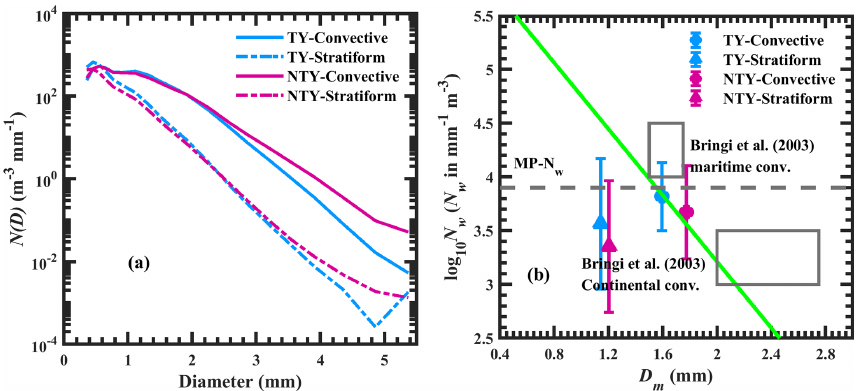
Figure 8. (a) Distribution of N(D) (m − 3 mm − 1 ) with raindrop diameter in stratiform and convective precipitation for typhoon (TY) and non-typhoon (NTY) rainfall. (b) Variations in log 10 N w (where N w is the normalized intercept parameter in mm − 1 m − 3 ) with D m (mass- weighted mean diameter in mm) in stratiform and convective regimes for typhoon (TY) and non-typhoon (NTY) rainfall. The horizontal gray dashed line is the Marshall–Palmer value of log 10 N w (3.9) for the exponential shape. The green inclined line is the stratiform and convective separation line of Bringi et al. (2003).